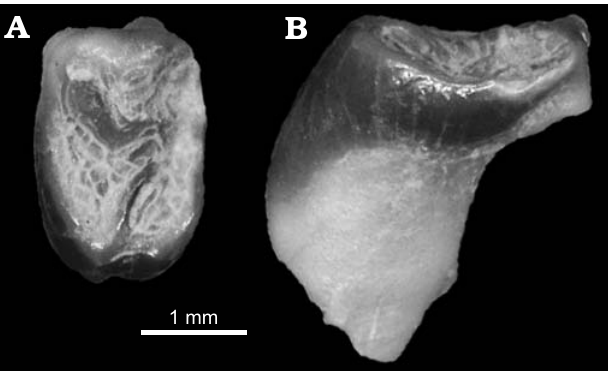
Fig. 5. Lagomorph Erenlagus anielae Fostowicz-Frelik and Li, 2014 from the Eocene of Wulanhuxiu, Nei Mongol, China. Left M1 (IVPP V20260) in occlusal ( A ) and posterior ( B